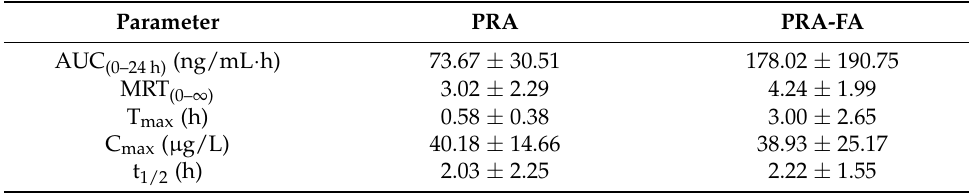
Table 4. Parameters of main hydrogen bonds for cocrystals.